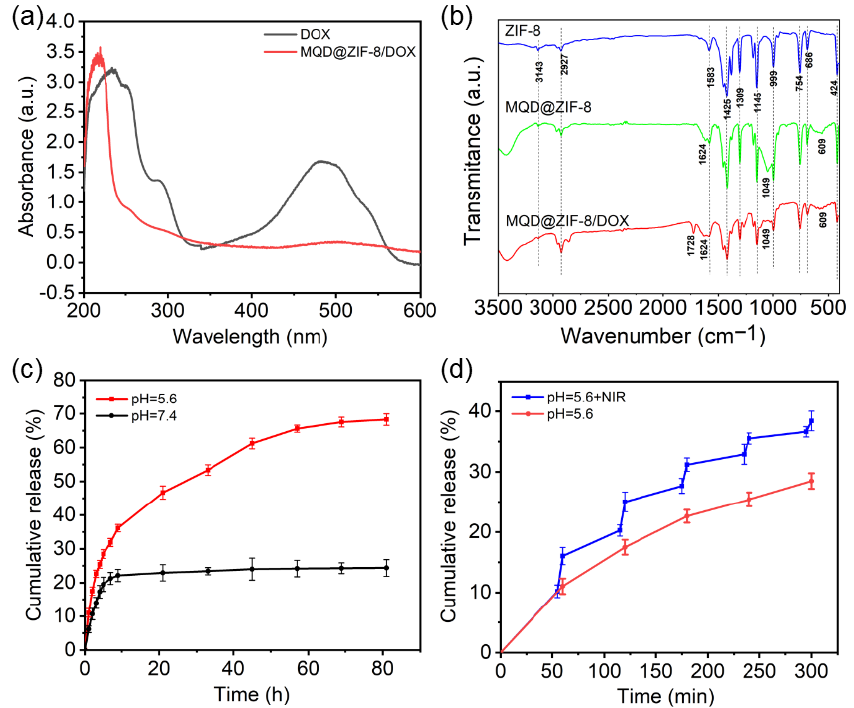
Figure 3. ( a ) UV–Vis absorption spectra of DOX and MQD@ZIF-8 /DOX; ( b ) FT-IR spectra of samples. ( c , d ) Release behaviors of MQD@ZIF-8/DOX under varied pH conditions and NIR irradiation.